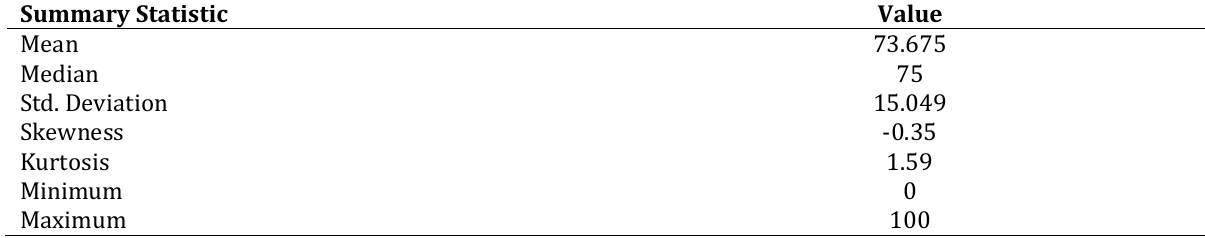
Table 9: Summary statistics of the level of sensitivity for robotics Summary Statistic